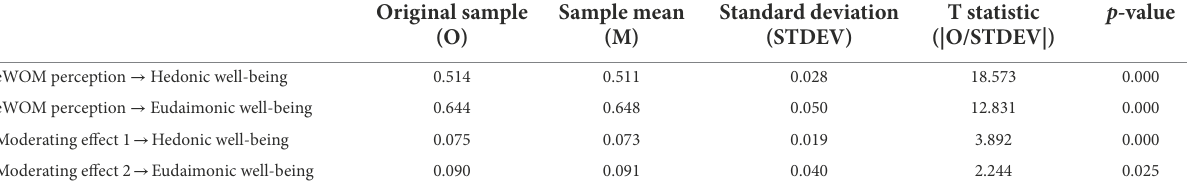
TABLE 4 Study 2: Path Coefficients under moderating effect (physical environment).